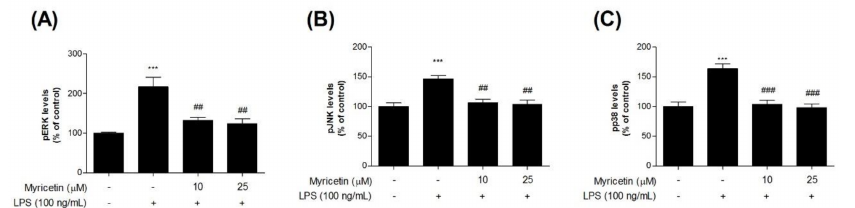
Figure 5. The e ff ect of myricetin on LPS-induced MAPK signaling by measuring p-ERK, p-JNK, and p-p38 levels in microglia BV2 cells. Cells were treated with myricetin for 1 h, and then stimulated with LPS for an additional 30 min or 23 h. ( a ) MAPK signaling p-ERK, ( b ) p-JNK, and ( c ) p-p38 levels were measured by ELISA kit. Values are means ± standard error of the mean. *** p < 0.001 compared to the control group, and ## p < 0.01 and ### p < 0.001 compared to the LPS-alone group. LPS, lipopolysaccharide; MAPK, mitogen-activated protein kinase; ERK, extracellular signal-regulated kinase; JNK, c-Jun NH2-terminal kinase, p38, p38 MAPK.